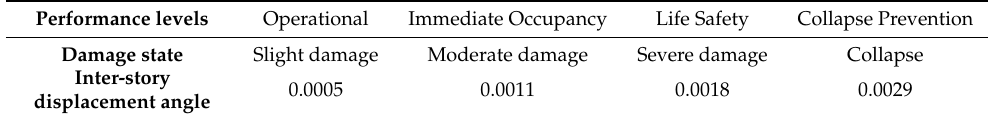
Table 4. Inter-story displacement angle limits of each performance